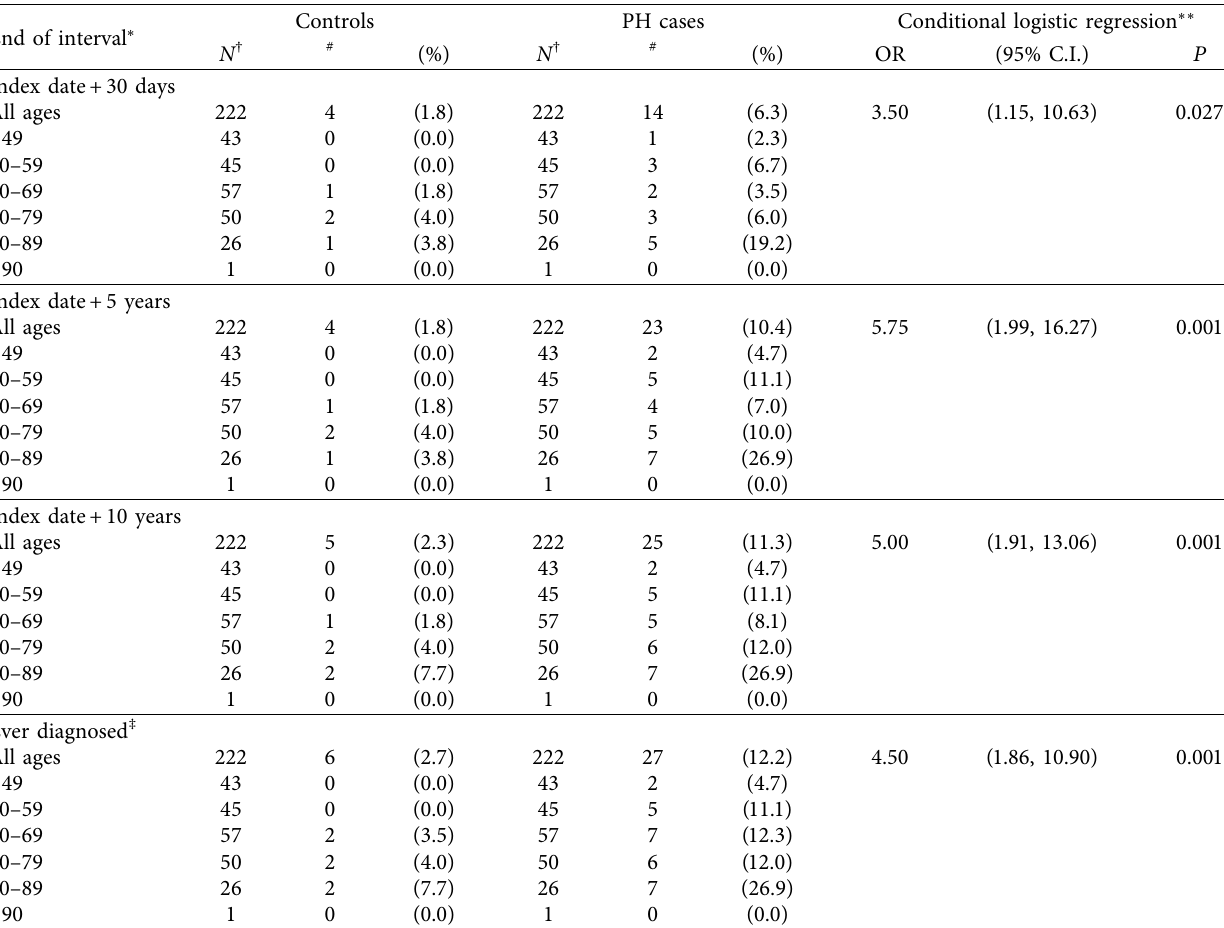
Table 3: Frequency of MGUS diagnosis among 222 PH cases using restrictive right heart catheterization criteria and their matched